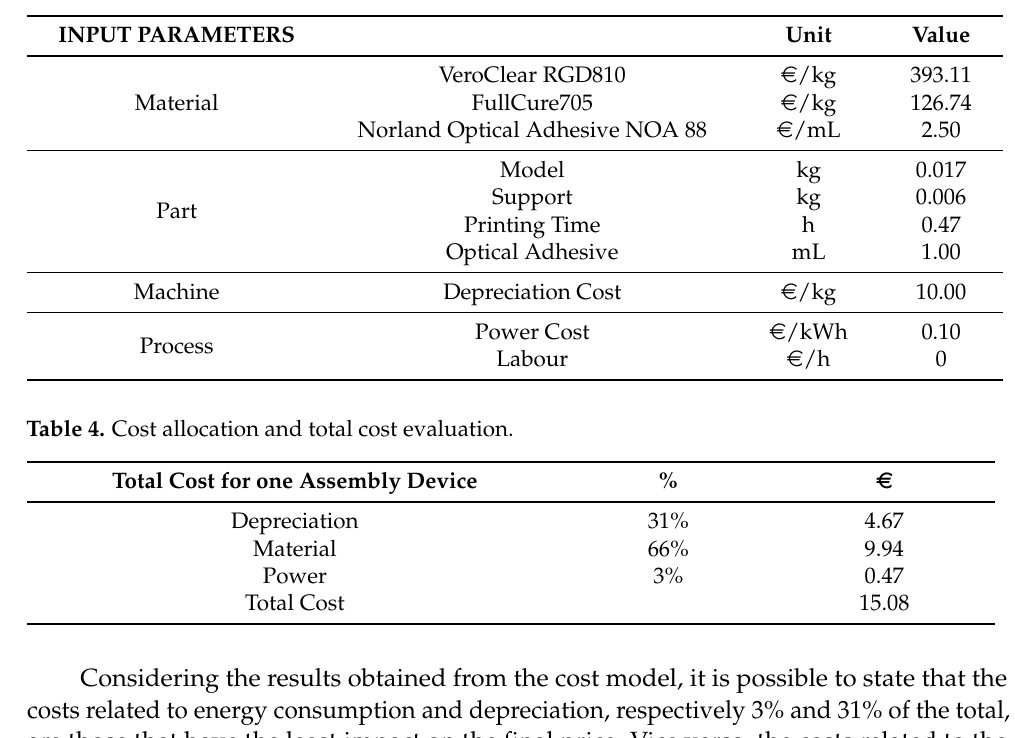
Table 3. Input parameters added to the cost model.